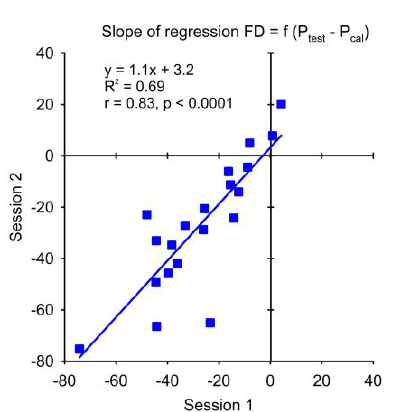
Figure 5: For the regression slope in Figure 3, the test-retest correlation between the two sessions is shown, after averaging the 12 individual measures in each